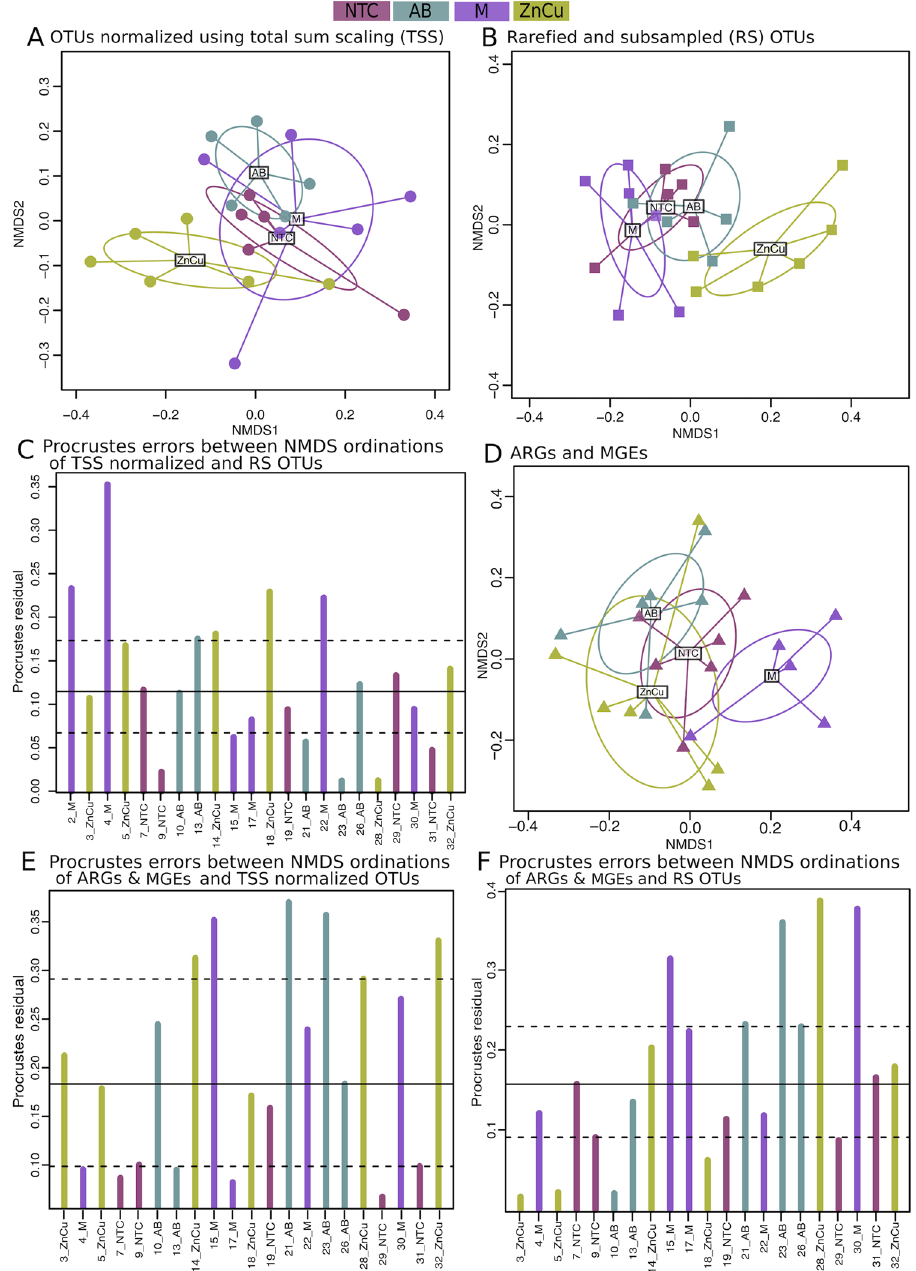
Figure 3. NMDS ordinations of TSS normalized OTUs, rarefied and subsampled OTUs and ARGs and MGEs and procrustes errors between them. Sample names are as follows: NTC non-treatment control, AB carbadox (antibiotic), M mushroom powder, ZnCu zinc oxide and copper sulfate. The number in the sample name denotes the number of the pen. ( A ) NMDS ordination of TSS normalized OTUs. ( B ) NMDS ordination of rarefied and subsampled (RS) OTUs. ( C ) Procrustes errors between NMDS ordinations of TSS normalized OTUs and rarefied and subsampled OTUs. ( D ) NMDS ordination of ARGs and MGEs. ( E ) Procrustes errors between NMDS ordinations of TSS normalized OTUs and ARGs and MGEs. ( F ) Procrustes errors between NMDS ordinations of rarefied and subsampled OTUs and ARGs and MGEs. The Procrustes residual error line plots ( C , E , F ) allow residual error size comparisons. The bars show the difference in the community structures between the two normalization methods ( C ) as well as the differences in community structure and resistome structure in samples belonging to different treatment groups ( E , F ). Horizontal lines denote the median (solid), 25% and 75% quantiles